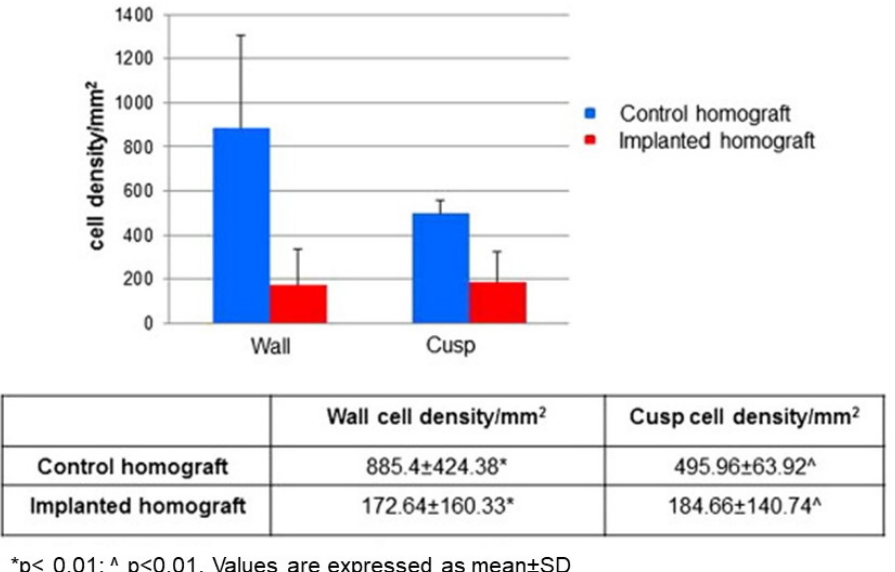
Figure 34. Histogram displaying cell density per millimeter squared in native vs. implanted decel- lularized conduit wall and cusps. A 20% repopulation occurred. All values are expressed as mean ± S.D. From [67].